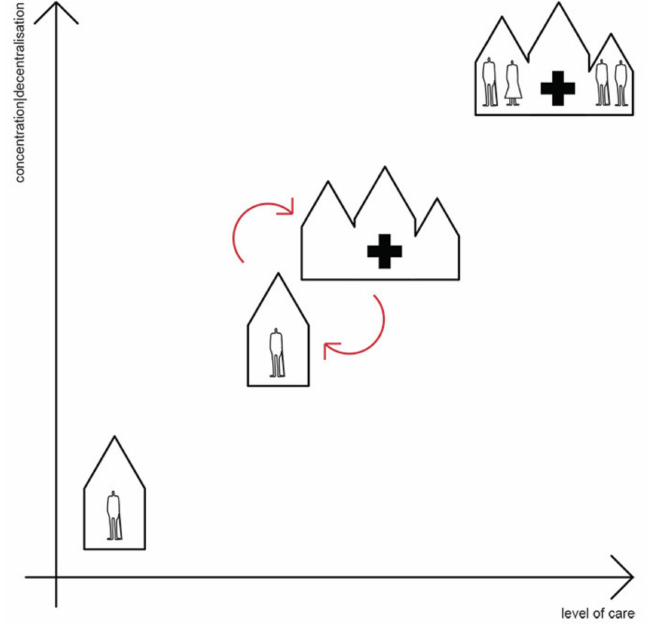
Figure 2 Flexibility of different care possibilities, c (cid:13) Davide